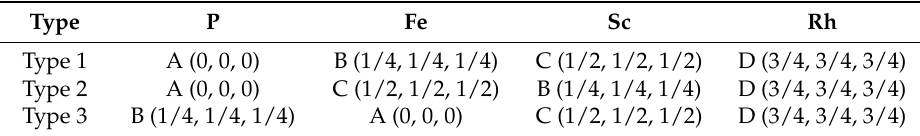
Figure 2. Three possible crystal structures ( a ) type 1, ( b ) type 2, ( c ) type 3 for ScFeRhP compound.